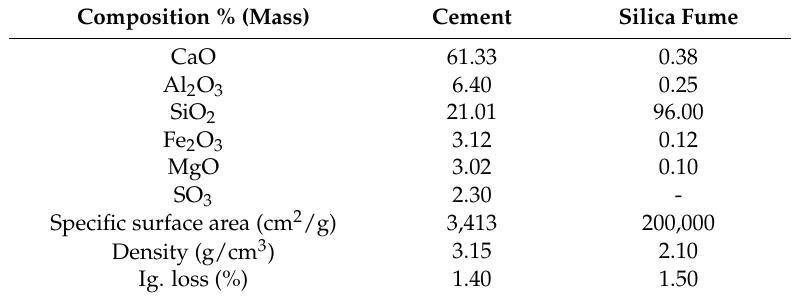
Table 1. Chemical compositions and physical properties of cementitious materials [32,33].